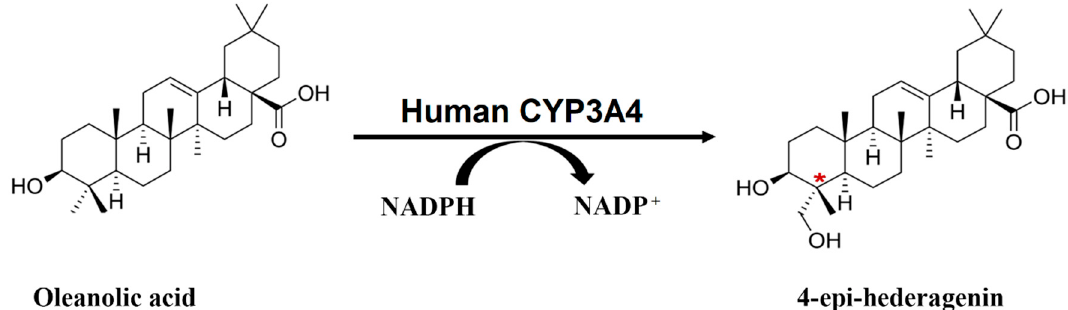
Figure 1. Chemical structures of oleanolic acid (OA) and 4-epi-hederagenin. CYP3A4 catalyzes the regioselective hydroxylation of OA to produce 4-epi-hederagenin in the presence of ß-nicotinaminde adenine dinucleotide phosphate (NADPH). The location of the alteration marked with a star is a chiral carbon generated by cytochrome P450 (CYP)-catalyzed hydroxylation.